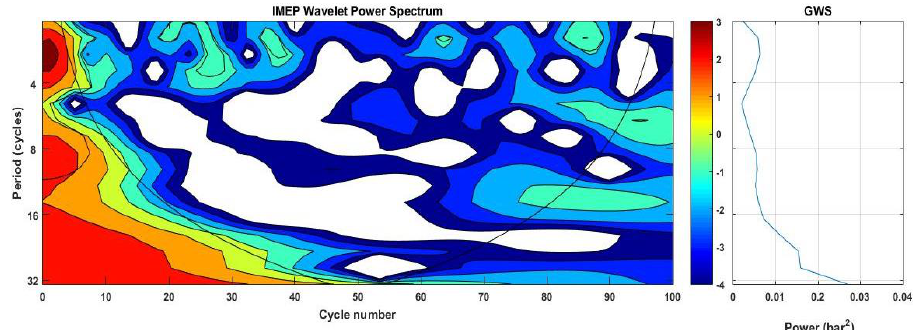
Figure 8. Wavelet analysis of IMEP (WPS and GWS), 10MPa_240BTDC_1720_Clean.